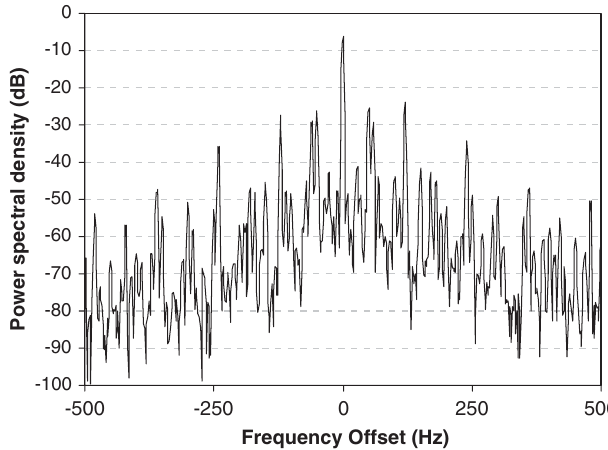
FIG. 8. Spectral output (dB) of cavity with shaker for injection locked magnetron and without DSP control, RBW ¼ 3 Hz .